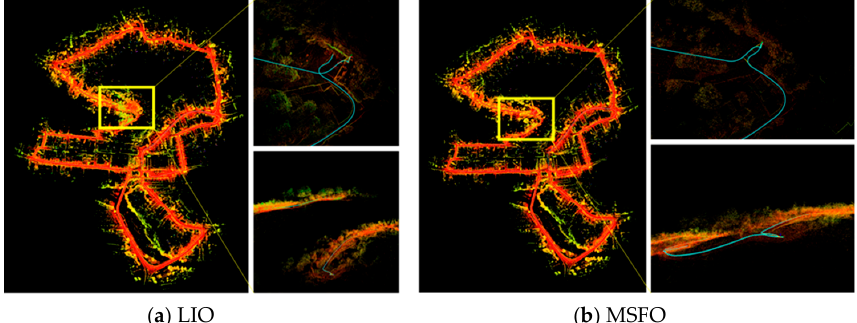
Figure 14. A comparison between LIO and MSFO from the point cloud reconstruction: error accu- mulation occurs when LIO returns to the origin and leads to point cloud stratification. Meanwhile, this situation does not occur in MSFO.